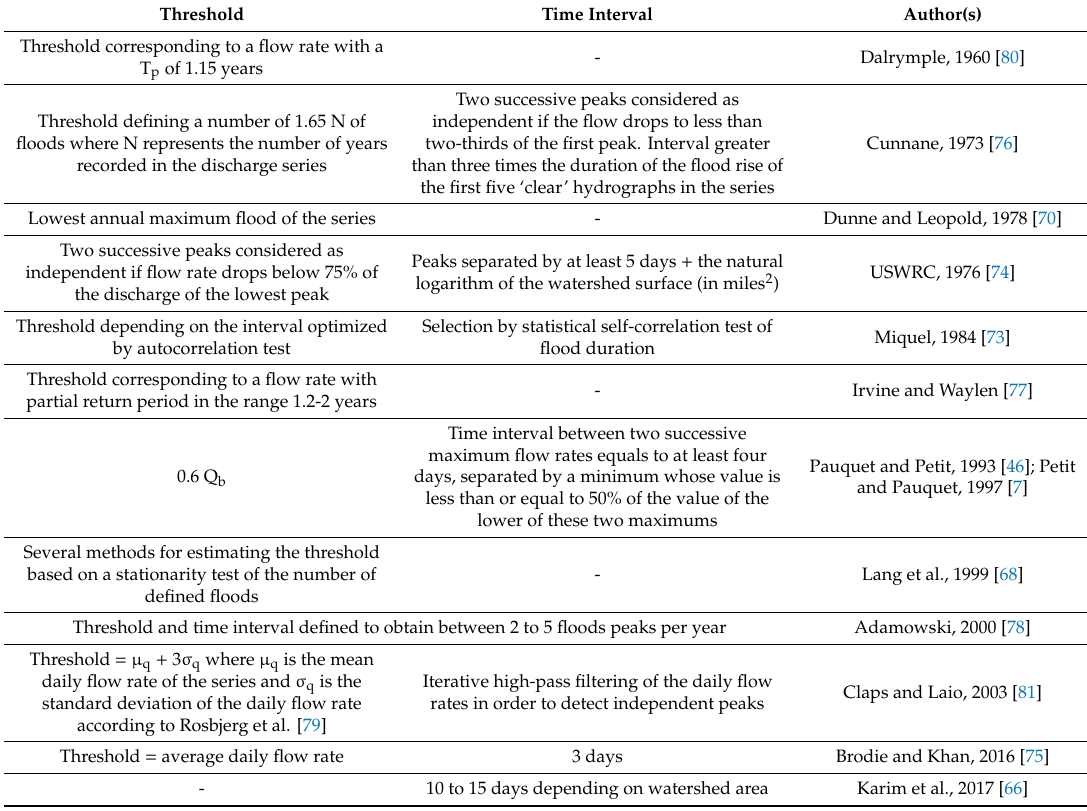
Table 2. Flow thresholds and time intervals between floods considered as independent in partial series Threshold Time Interval Author(s)